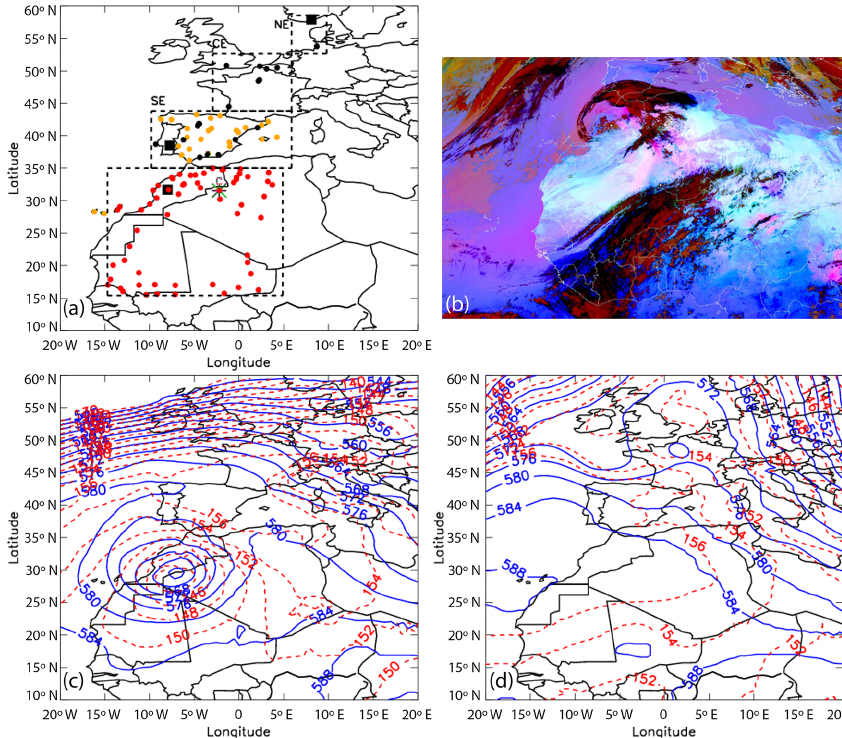
Figure 1. Panel (a) : AERONET (orange), surface concentration (black), surface wind (green) and radio sounding (brown) stations used in this study are presented. Southern, central and northern European (SE, CE and NE, respectively, as the dashed black squares) regions used in the statistical analysis are illustrated, as well as the region used to produce the emission time series in Fig. 5. Panel (b) : the MSG/RGB (Meteosat Second Generation/Red Green Blue) dust product of the Spinning Enhanced Visible and Infrared Imager (SEVIRI) shows the cloud band of the cyclone (red) and dust aerosol (pink) of the dust event over northwest Africa on 5 April 2011 at 12:00UTC. Panel (c) : geopotential height at 500hPa (blue lines); panel (d) : geopotential height at 850hPa (red lines) for 5 and 10 April 2011 and wind field at